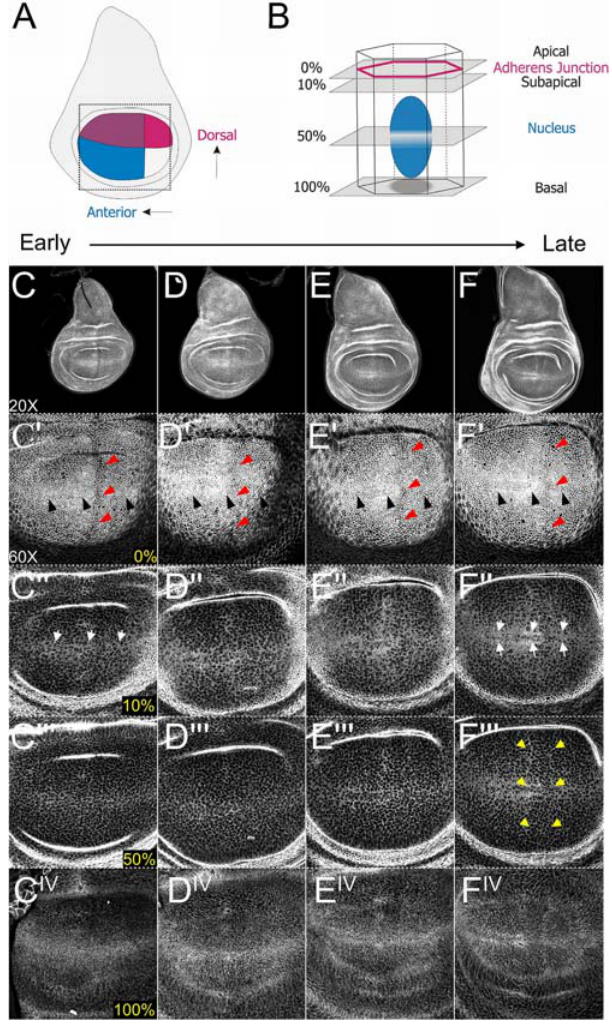
Figure 4. Distribution of Armadillo through 3 rd instar larval wing disc development. (A) Diagrammatic representation of a third instar larval wing disc, highlighting the compartments of the wing pouch formed by intersecting Anterior/Posterior (A/P) and Dorsal/ Ventral (D/V) boundaries. The dashed box outlines the confocal view at 60 6 magnification. (B) Diagrammatic representation of apicobasal confocal sections through a single cell of the epithelium, with AJs in red and the nucleus shown in blue. The AJ is considered to be the 0% baseline, with subapical (top 10%), midcellular (50%) and basal (100%) reference points shown. (C–F) The subcellular distribution of endoge- nous Armadillo changes throughout the development of the 3 rd instar larval wing disc as assessed by Armadillo-GFP under the Armadillo promoter [52]. Panels C to F show subsequently older wing discs at 20 6 magnification. Panels C 9 to F IV show changes in subcellular localisation of Armadillo in discs of similar age to C–F at 60 6 magnification. (C 9 –F 9 ) Cells at the level of the AJ (0%). Note the distribution of cells along the A/P boundary (red arrowheads), forming a ‘‘line’’ of cells. A single row of cells in early 3 rd instar (C 9 ) becomes a series of aligned cells along the D/ V boundary by the late 3 rd instar in response to Wg and Notch signalling (F 9 black arrowheads). (C 0 –F 0 ) Within the top 10% of the cell, Armadillo has a punctate distribution within the domain of Wg signalling (C 0 ) that resolves into a tramtrack pattern around the D/V domain of expression (F 0 , white arrows). (C 90 –F 90 ) In addition, at approximately 50% of cell height Armadillo puncta are also stabilised in two vertical stripes along either side of the Hh signalling domain (F 90 yellow arrowheads), most visibly dorsally. These patterns are evident at the basalmost point in the cell as well (C IV –F IV ) The antibody staining with N27A1 recapitulates that of the Armadillo-GFP (not shown).